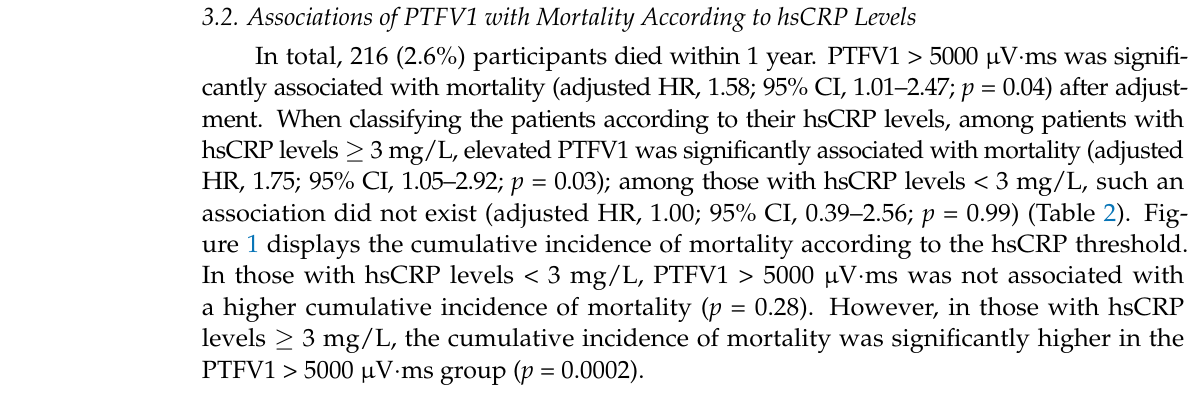
Table 2. Associations between PTFV1 and mortality within 1 year according to hsCRP